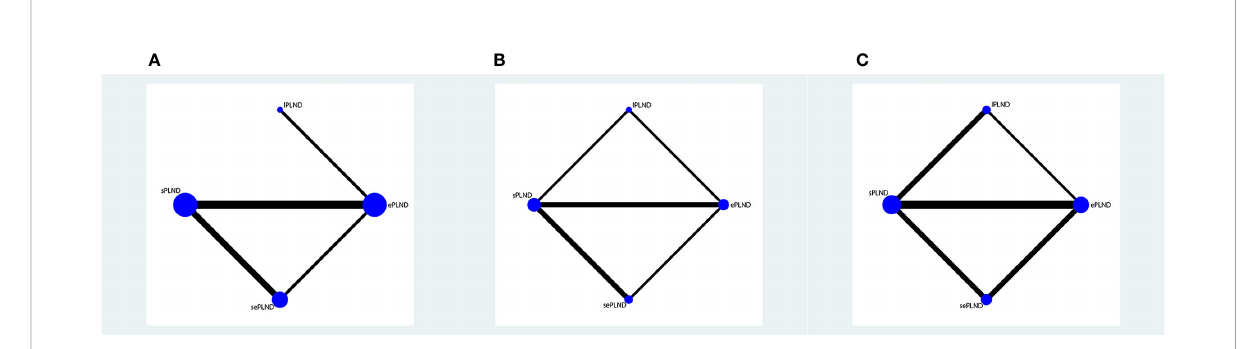
FIGURE 4 (A) Network plot showing the association of different PLND templates with the RFS in patients undergoing radical cystectomy. (B) Network plot showing the association of different PLND templates with the DSS in patients undergoing radical cystectomy. (C) Network plot showing the association of different PLND templates with the OS in patients undergoing radical cystectomy. PLND, Pelvic lymph node dissection. RFS, Recurrence free survival. PLND, Pelvic lymph node dissection. DSS, Disease speci fi c survival. OS, Overall survival. lPLND, limited pelvic lymph node dissection. sPLND, standard pelvic lymph node dissection. ePLND, extended pelvic lymph node dissection. sePLND, super-extended pelvic lymph node dissection. Note: Lymph node dissection templates are represented by nodes and direct comparison trials between different templates are linked with a line. The area of the dot represents the sample size of each template and the width of the line corresponds the number of direct comparison trials.